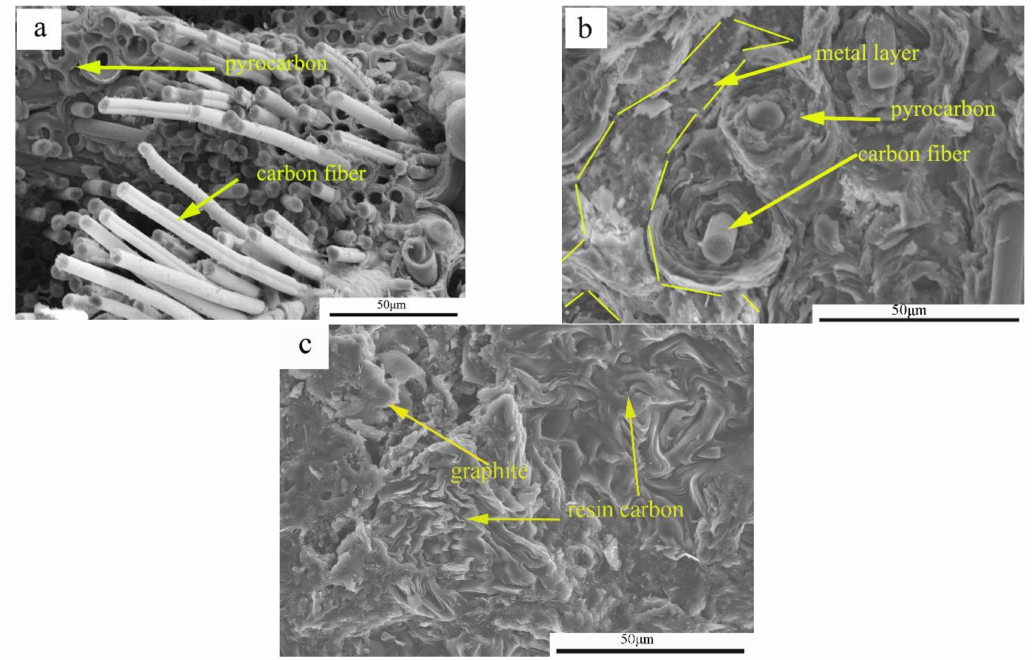
Figure 3. Fracture micro-morphology of C/C, C/C–Al–Cu, and pure carbon slide composites. ( a ) Bending fracture morphology of C/C; ( b ) bending fracture morphology of C/C–Al–Cu; and ( c ) bending fracture morphology of pure carbon